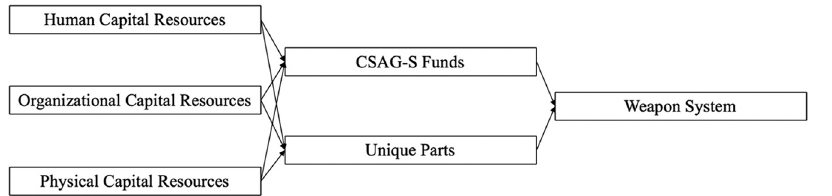
Figure 4. RBV risk factors